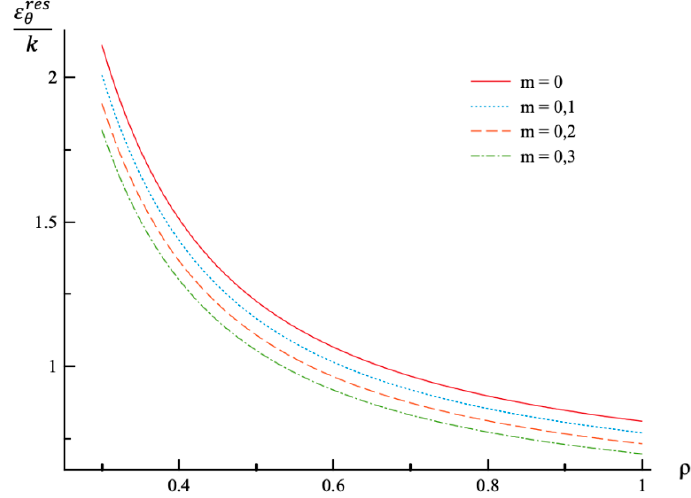
Figure 9. Variation of the residual circumferential strain, ε res